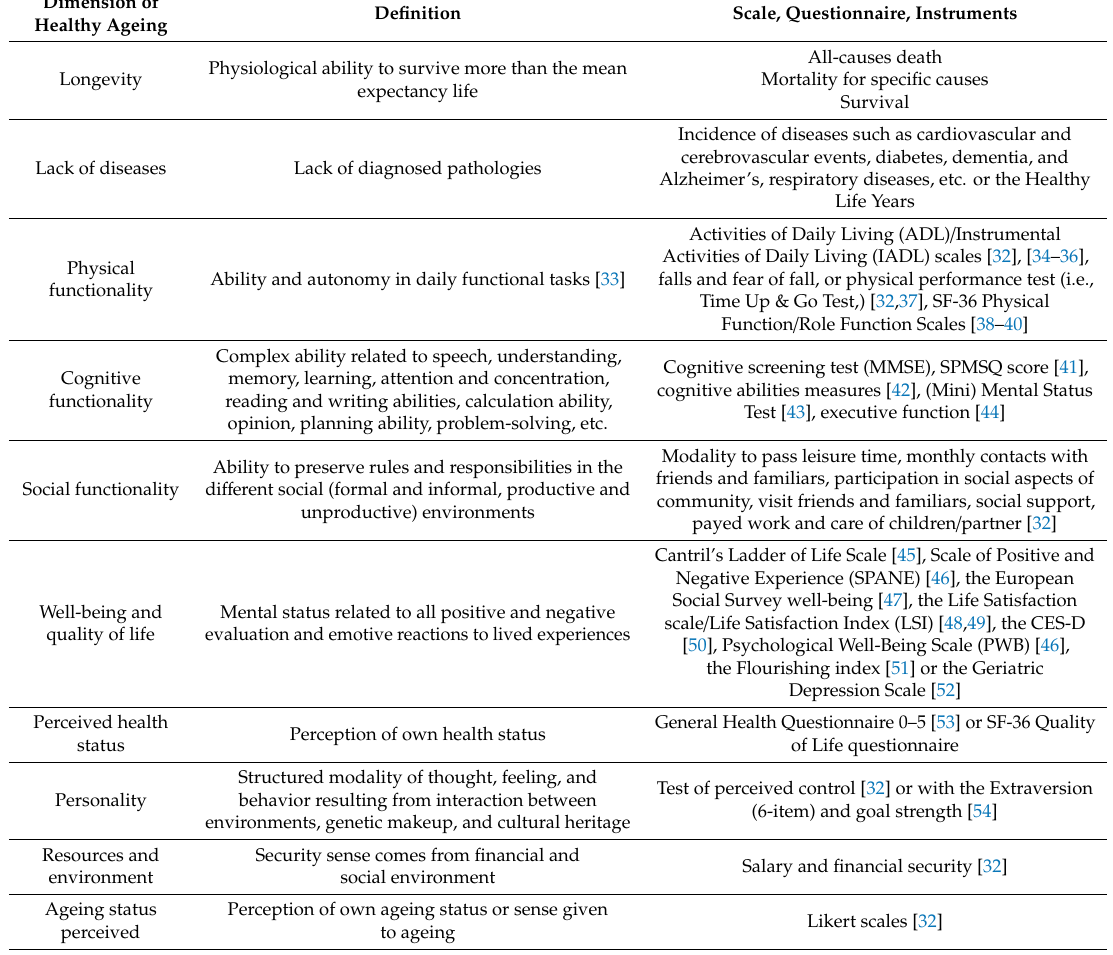
Table 1. Dimensions and definitions of healthy ageing concept and instruments for measurements. Following a systematic review [32], table reports on the first ten dimensions of healthy ageing concept more frequently analyzed in clinical studies on